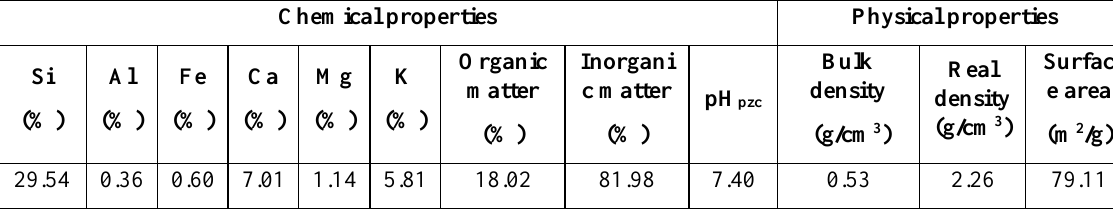
Table 1: Chemical and physical properties of SBFA.